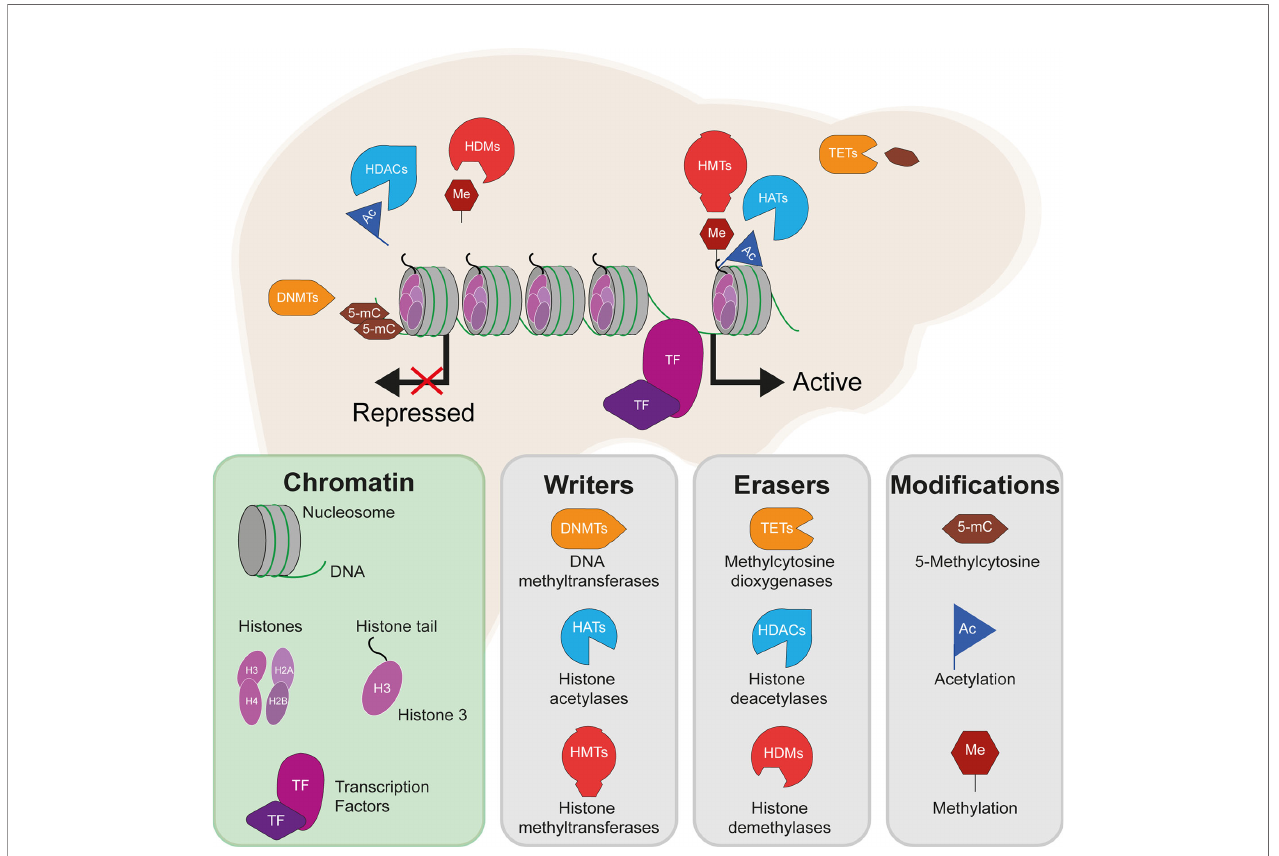
FIGURE 1 | DNA methylation, histone methylation and acetylation and their epigenetic machinery: sources of gene regulation in the liver. Repressed gene expression is shown where epigenetic modi fi ers remove active histone marks (e.g. H3K27ac and methylation of H3K4), including histone deacetylases (HDACs) and histone demethylases (HDMs). Active gene expression is shown where active histone marks are deposited by histone acetyltransferases (HATs) and histone methyltransferases (HMTs). DNA methylation is here shown to repress gene expression, which typically occurs following the methylation of gene promoters and is deposited by DNA methyltransferases (DNMTs) and removed by methylcytosine dioxygenases (TET